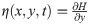
Numerical simulation of the reduced model showed the scaling predicted by the mathematical analysis.(a) Dispersion relation of the full model (blue) and its approximation by λ(k) ∝ kγ (red). The parameter set was a = 1, b = 0.1, c = 0.48, and r = 1. Domain size = 20π and Δx = 0.2π. We defined H(x, y, t) as a white noise and obtained η(x,y,t)=∂H∂y at each time step. We used cutoff frequency ωc = 0.8 to obtain this differentiation. (b) Result of the numerical simulation. The upper panel shows the initial shape (t = 0); the lower panel shows the curved shape obtained after sufficient time had passed (t = 2000). (c) Log–log plots of the average of h^2 obtained by numerical simulations. A region of linear scaling was observed in the high wavenumber region. (d–f) Time course of the log–log plots of the power spectrum obtained by numerical simulations. (d) t = 0, (e) t = 1000, and (f) t = 10000. (g) The relationship between surface roughness w and system size L. (h) The relationsip between surface roughness w and time t.